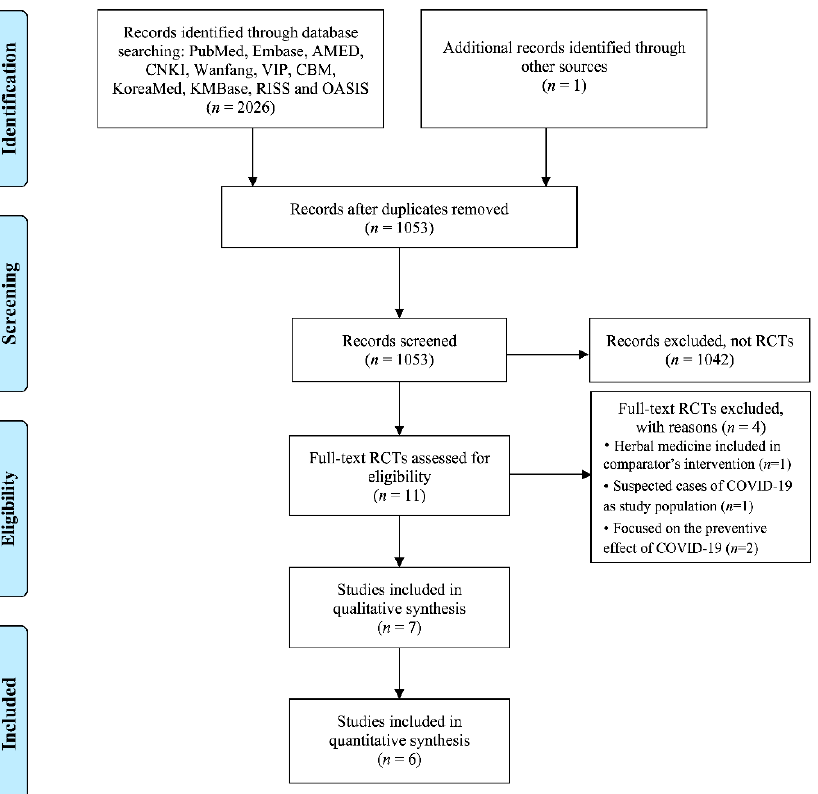
Figure 1. Flowchart of the literature search and study selection. COVID-19: coronavirus disease 2019; RCT: randomized controlled trial.